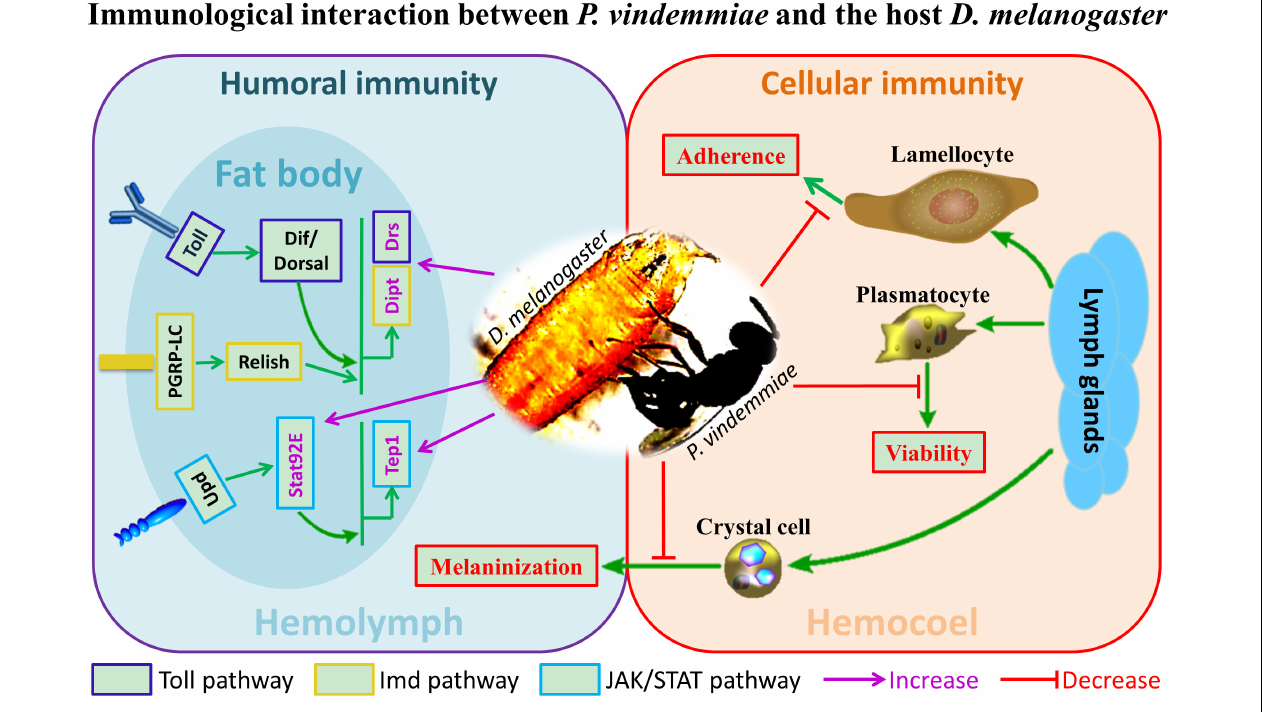
FIGURE 9 | The schematic representation of immunological interaction between P. vindemmiae and the host D.